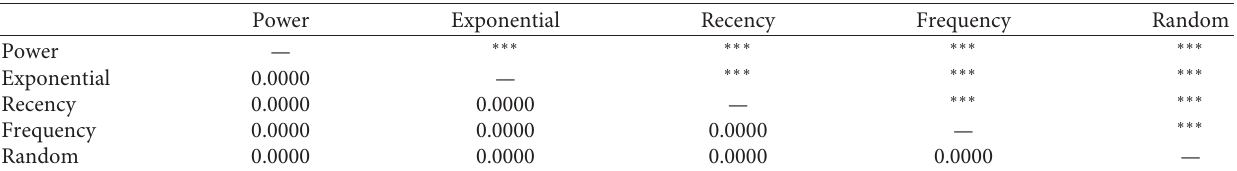
Table 1: Numerical and symbolic p values adjusted by Simes–Hochberg step-up method of nonparametric pairwise post hoc Nemenyi test comparing values of Jaccard metric for results obtained by each method with parameters fitted using recorded event data with the ground truth based on surveys taken over semesters 1–4.